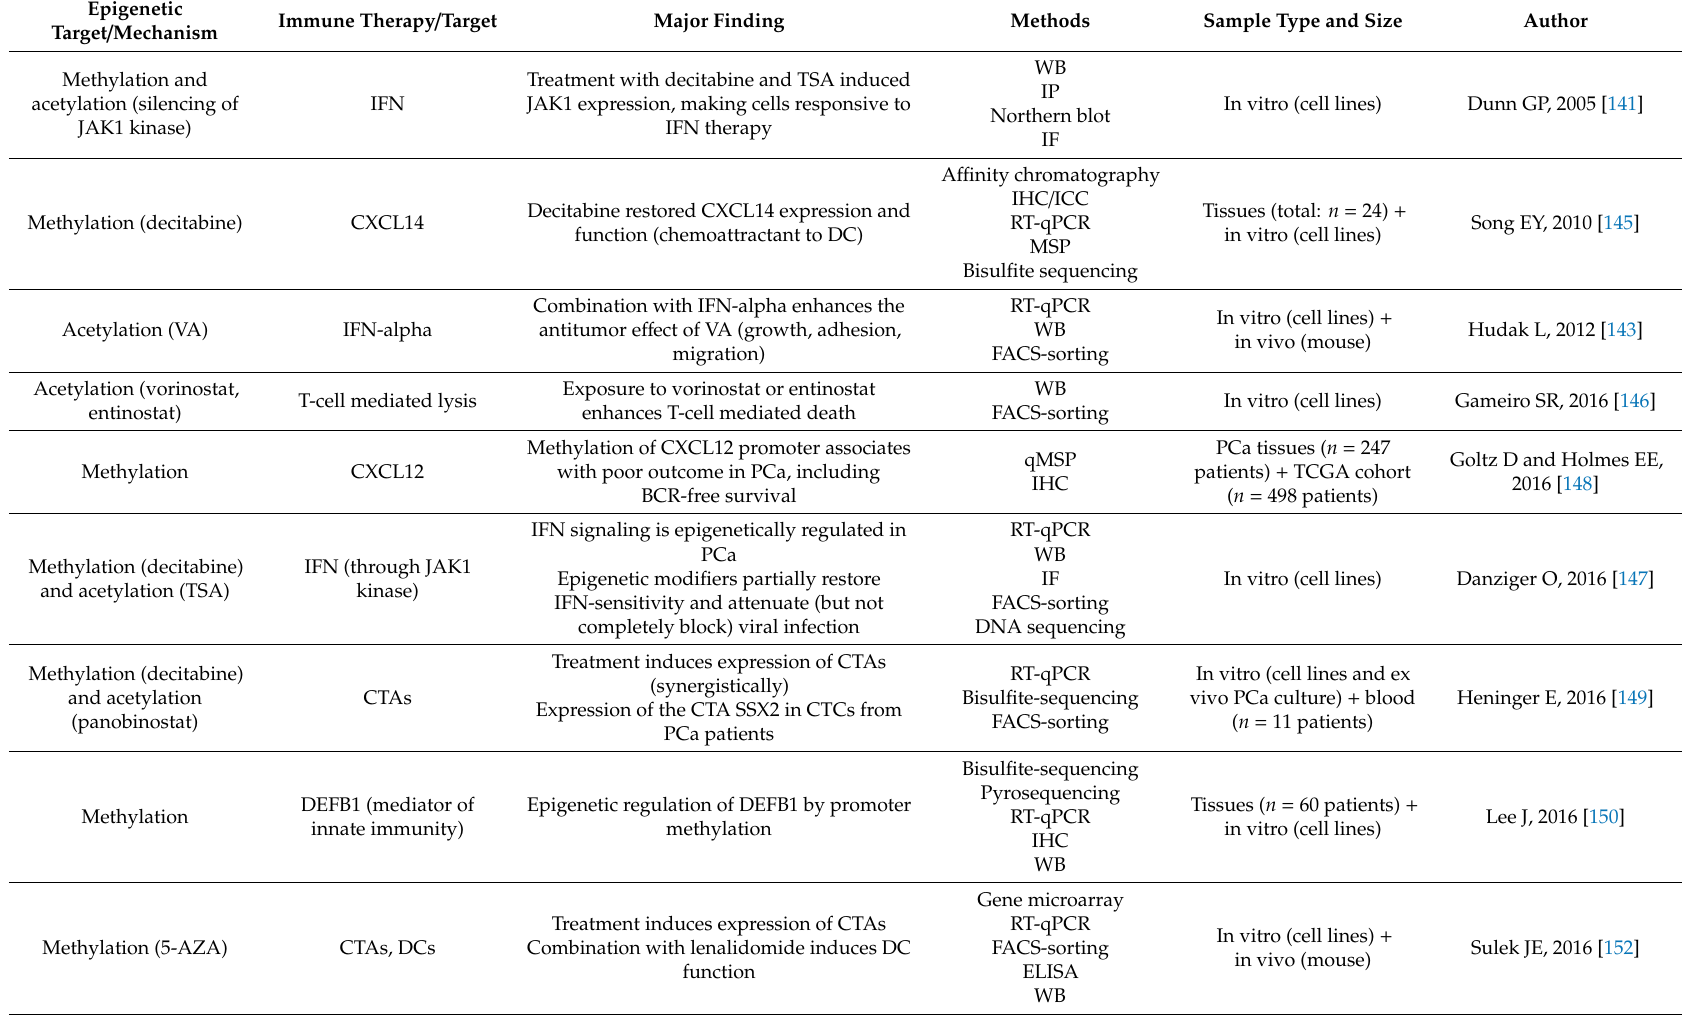
Table 3. Immunoepigenetic-based studies in Prostate